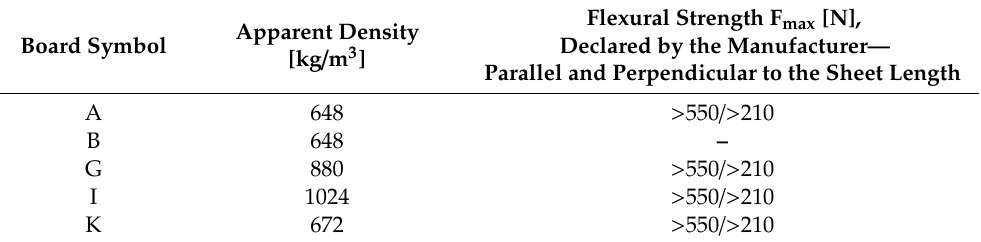
Table 2. Mechanical properties of tested plasterboard compositions